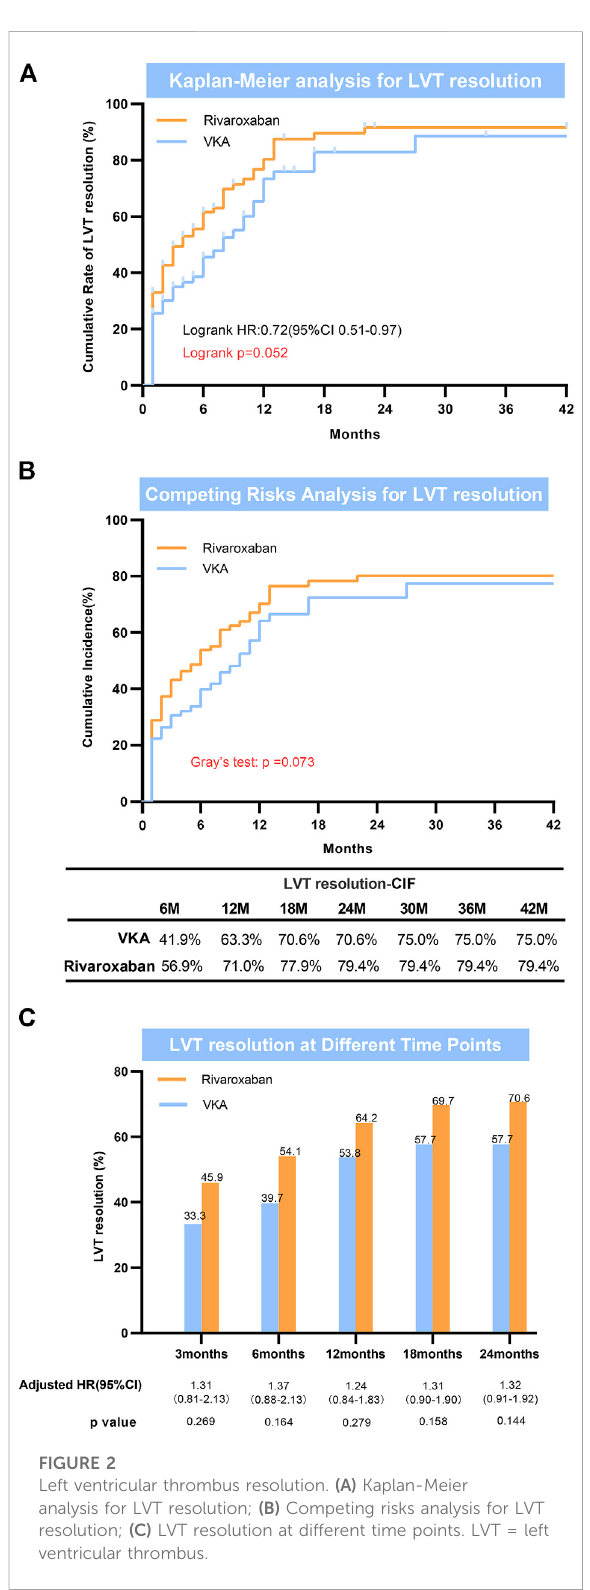
FIGURE 2 Left ventricular thrombus resolution. (A) Kaplan-Meier analysis for LVT resolution; (B) Competing risks analysis for LVT resolution; (C) LVT resolution at different time points. LVT = left ventricular